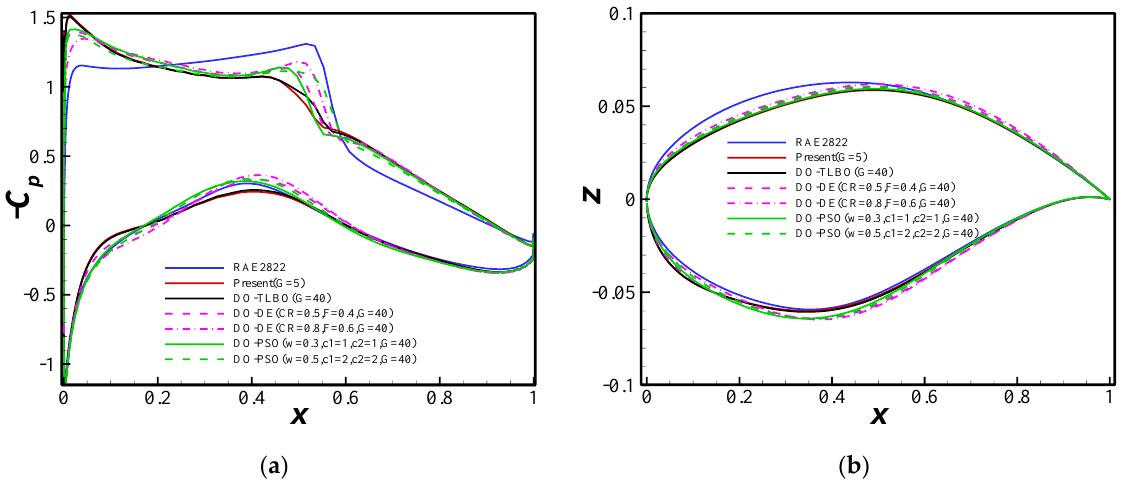
Figure 8. Comparisons of C p and airfoil shapes with the optimized airfoils. ( a ) C p distribution; ( b ) airfoil shapes.